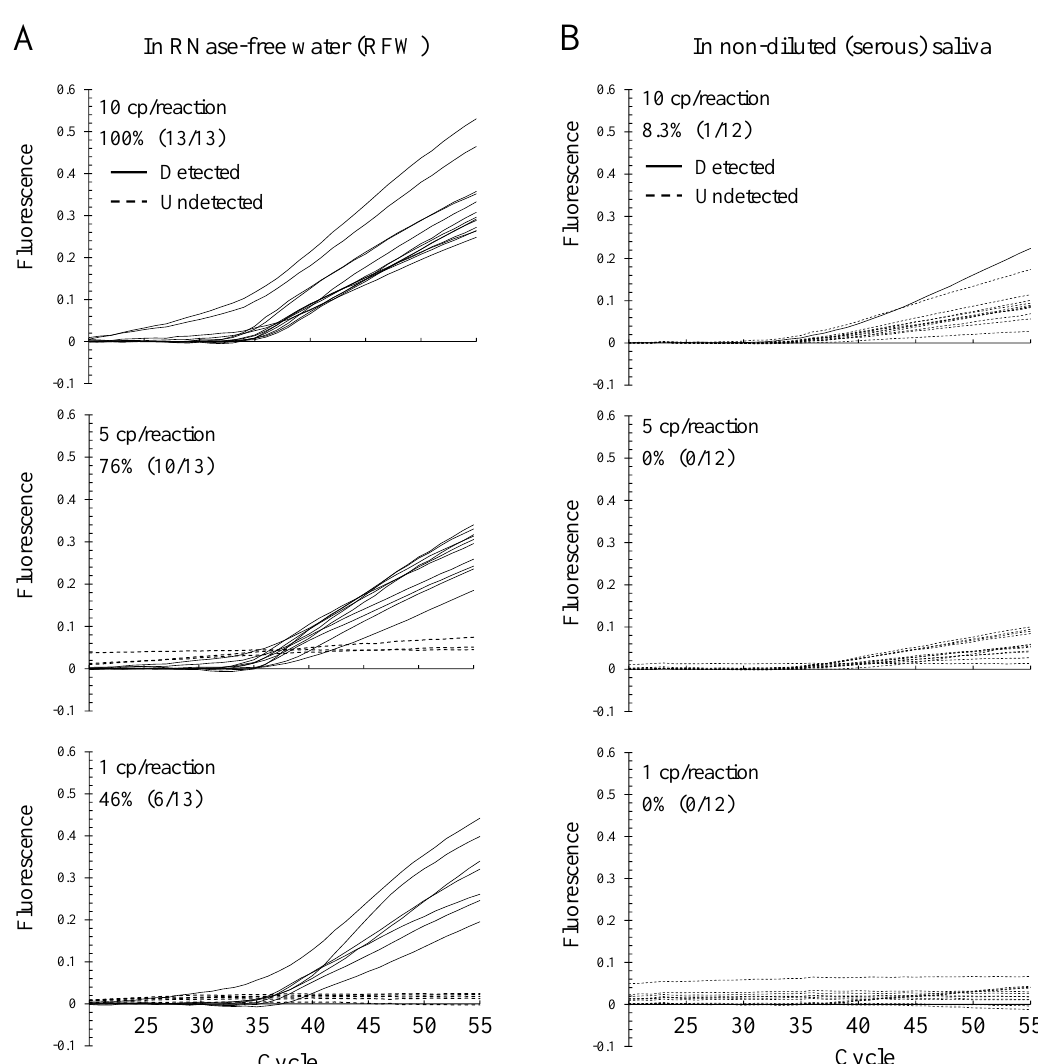
Figure 4. Detection rate of N2 in samples containing low concentrations of SARS-CoV-2 RNA. ( A ) Detected (solid line) and undetected (dashed line) amplification curves of the N2 gene in RFW. ( B ) Detected (solid line) and undetected (dashed line) amplification curves of the N2 gene in non-diluted saliva. SARS-CoV-2 RNA STDs (10, 5, and 1 cp/reaction) were used for confirming the detection limit. Percentages indicate detection rates (detected samples/total